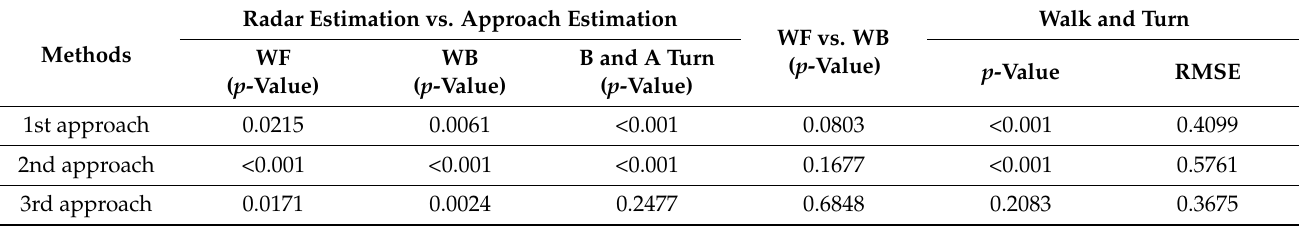
Table 2. p -values of the tested approaches using a pairwise Wilcoxon signed rank test and the root mean square error. Radar Estimation vs. Approach Estimation Methods